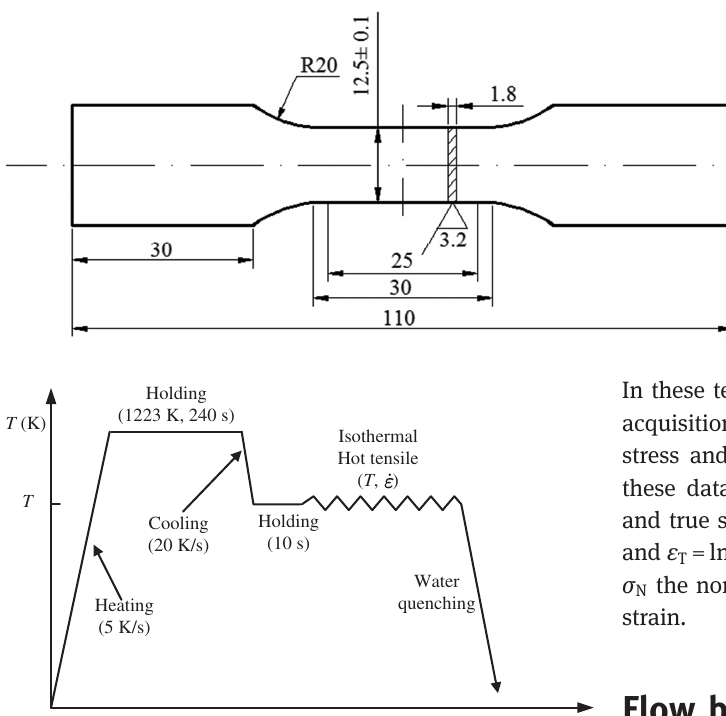
Figure 2: Experimental procedures for the isothermal uniaxial hot tensile tests.